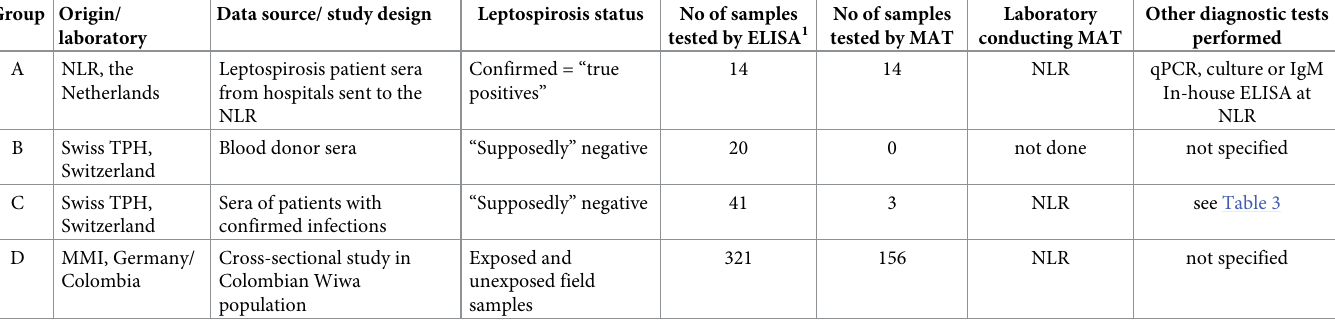
Table 2. Overview of origin of serum samples, diagnostic tests and laboratories involved in the evaluation of the Serion IgM ELISA (REF EST125M), which was per- formed at the Swiss Tropical and Public Health Institute (Swiss TPH), Basel, Switzerland. Group Origin/